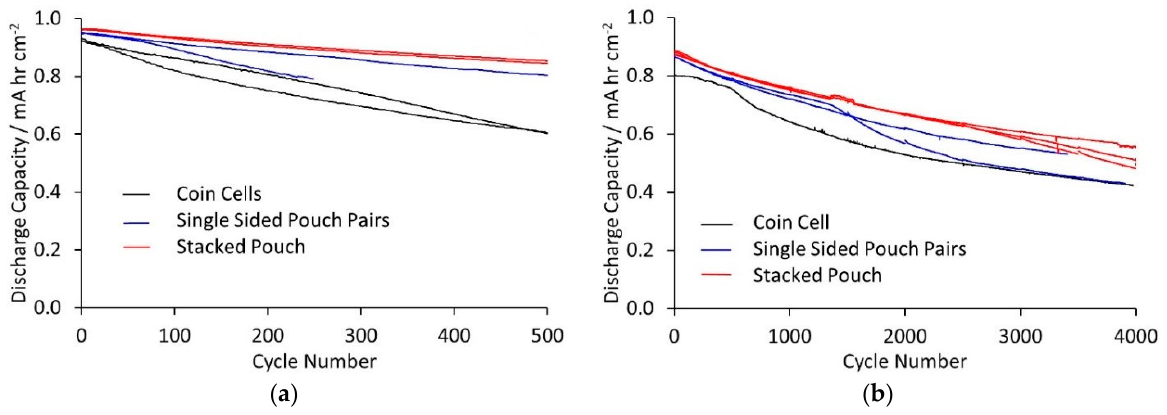
Figure 2. Discharge capacities during cycling at ( a ) ±C/2 and ( b ) ±3 C.